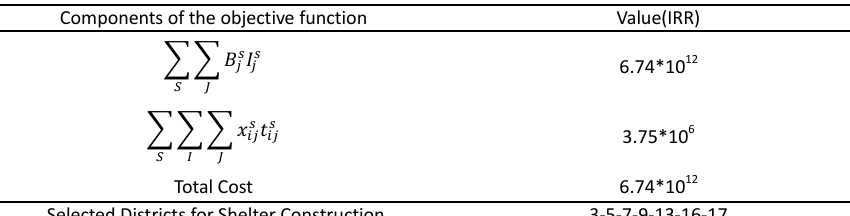
Fig. 2: Vulnerable population, , of the 22 districts of Tehran (Edrissi, et al., 2015) 𝑷𝑷 𝒊𝒊 𝒒𝒒 𝒊𝒊 Table 3: The final result of the objective function